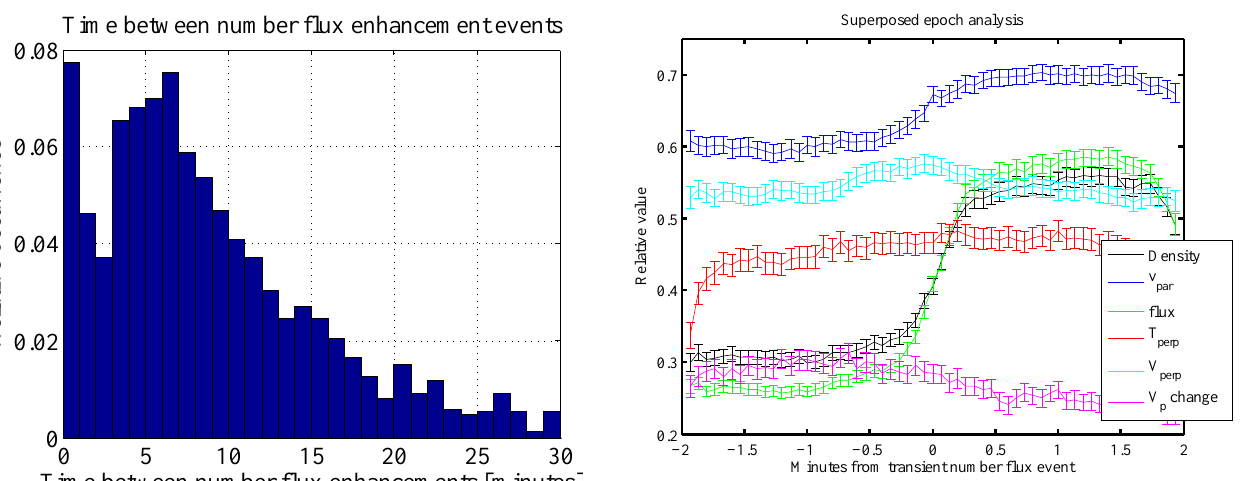
Fig. 3. Distribution of the time interval between number flux en- hancement events. The x-axis shows the time between number flux enhancement events [minutes]. The y-axis shows the occurrence frequency.